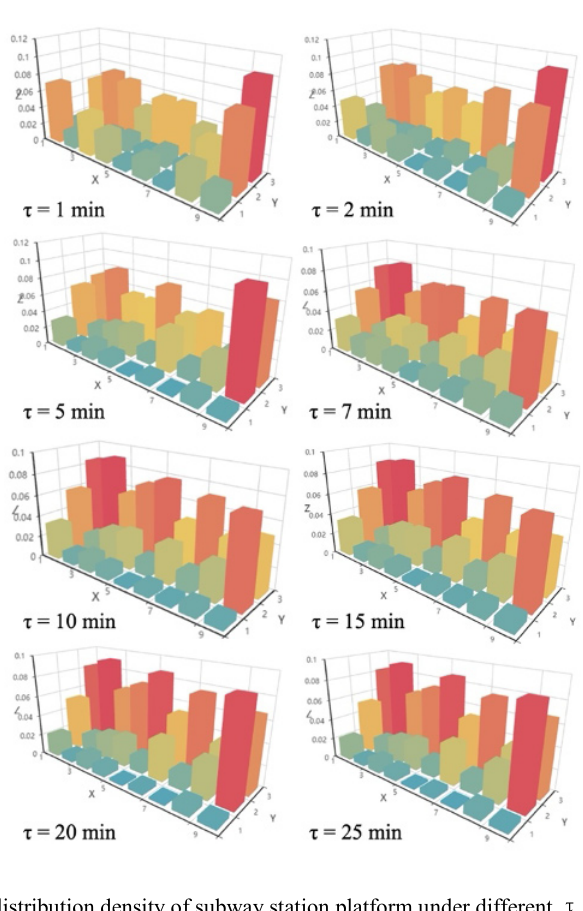
Fig. 3. Personnel distribution density of subway station platform under different τ .